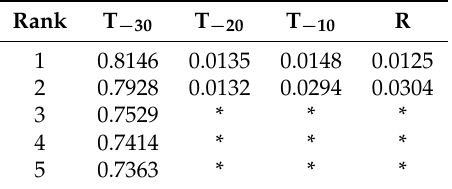
Table 1. Top 5 values of T − 30 at 2.75 eV in the non-empirical search for the metagrating in Figure 6c. The mark * denotes that data are not available since they were of less interest and not collected. Rank T − 30 T − 20 T − 10 R 1 0.8146 0.0135 0.0148 0.0125 2 0.7928 0.0132 0.0294 0.0304 3 0.7529 * * * 4 0.7414 * * * 5 0.7363 * *